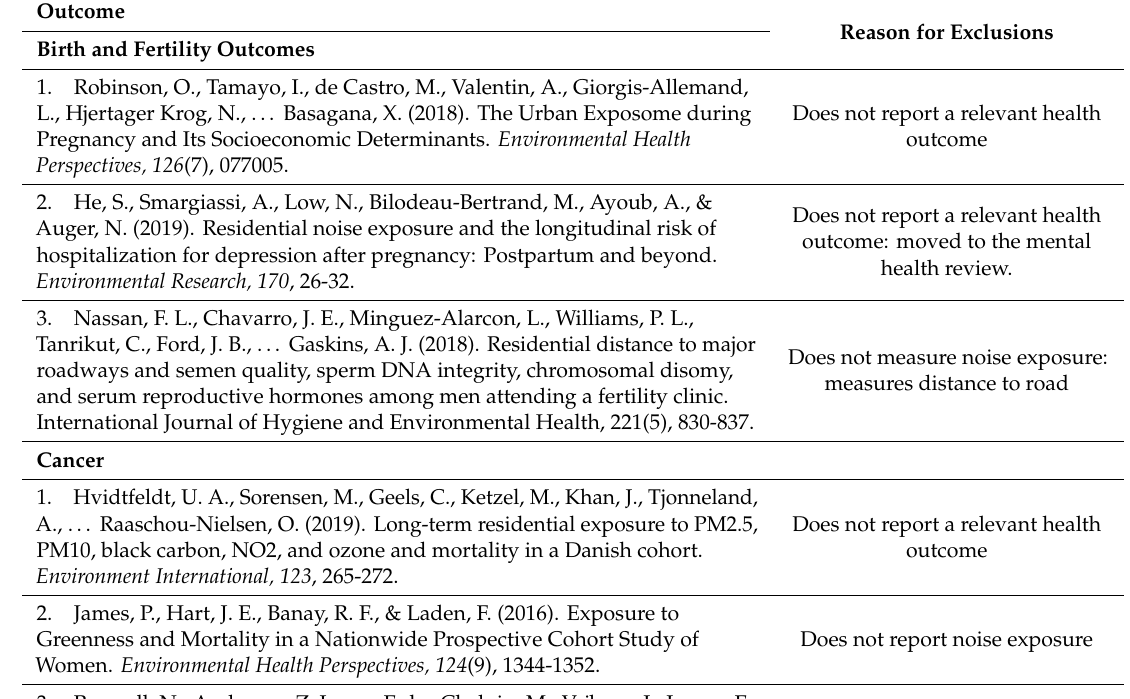
Table A2. Excluded